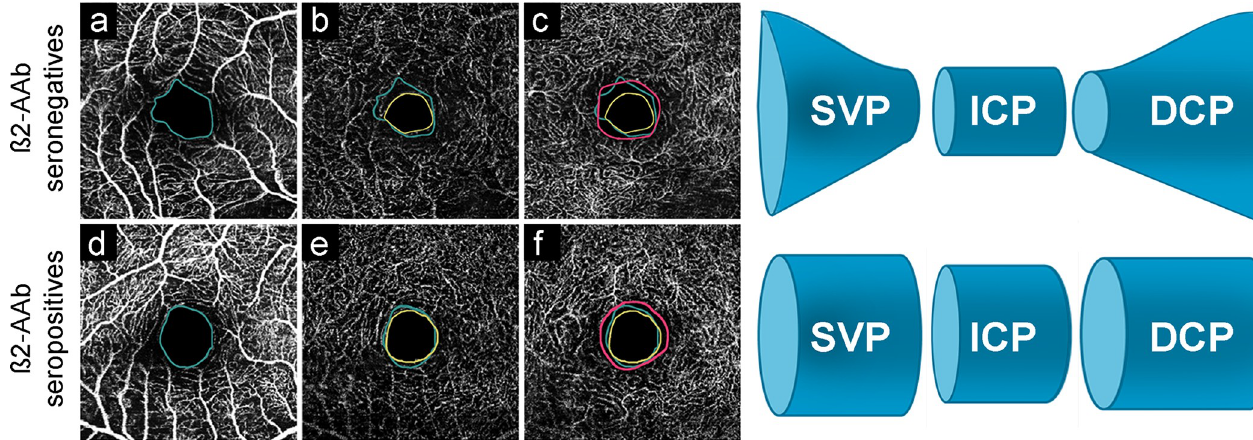
Fig 6. FAZ of superficial vascular plexus (SVP; green; a, d), intermediate capillary plexus (ICP; yellow; b, e), and deep capillary plexus (DCP; pink; c, f) in a β 2-agAAb seronegative (a-c) and seropositive (d-f) OAG patient including a schematic sketch of the FAZ of SVP, ICP, DCP considering β 2-agAAb